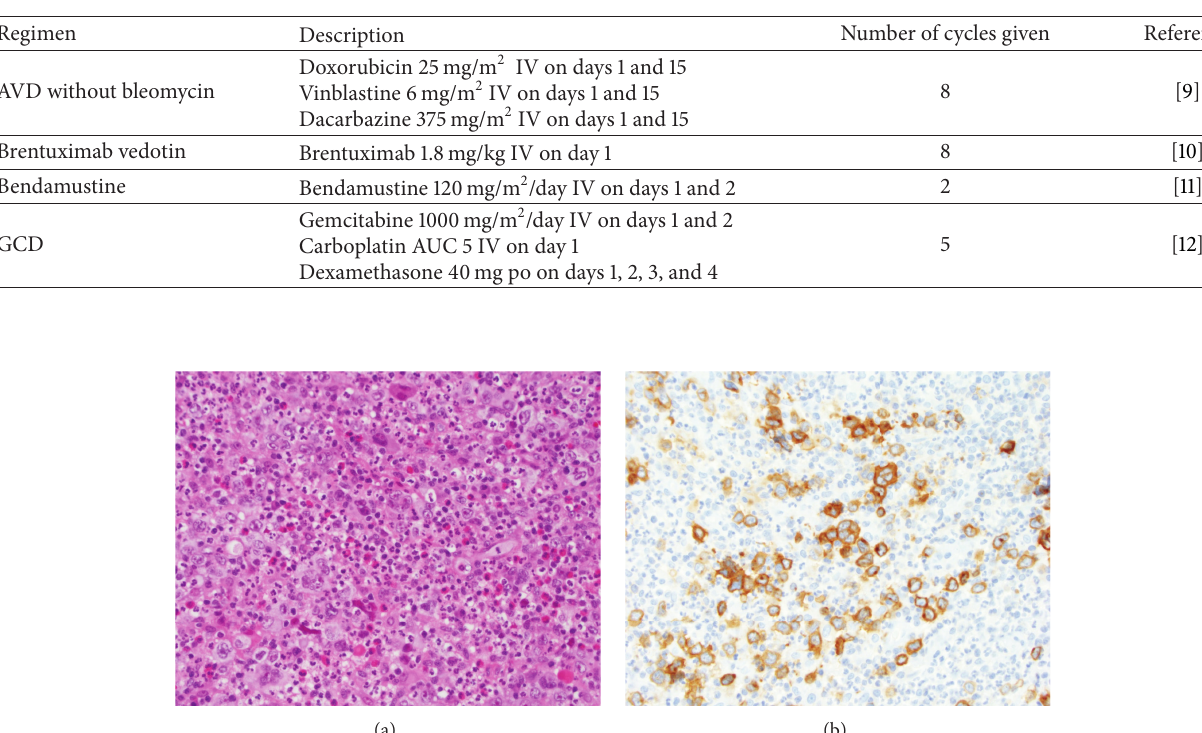
Table 1: List of chemotherapy agents utilized in our case.